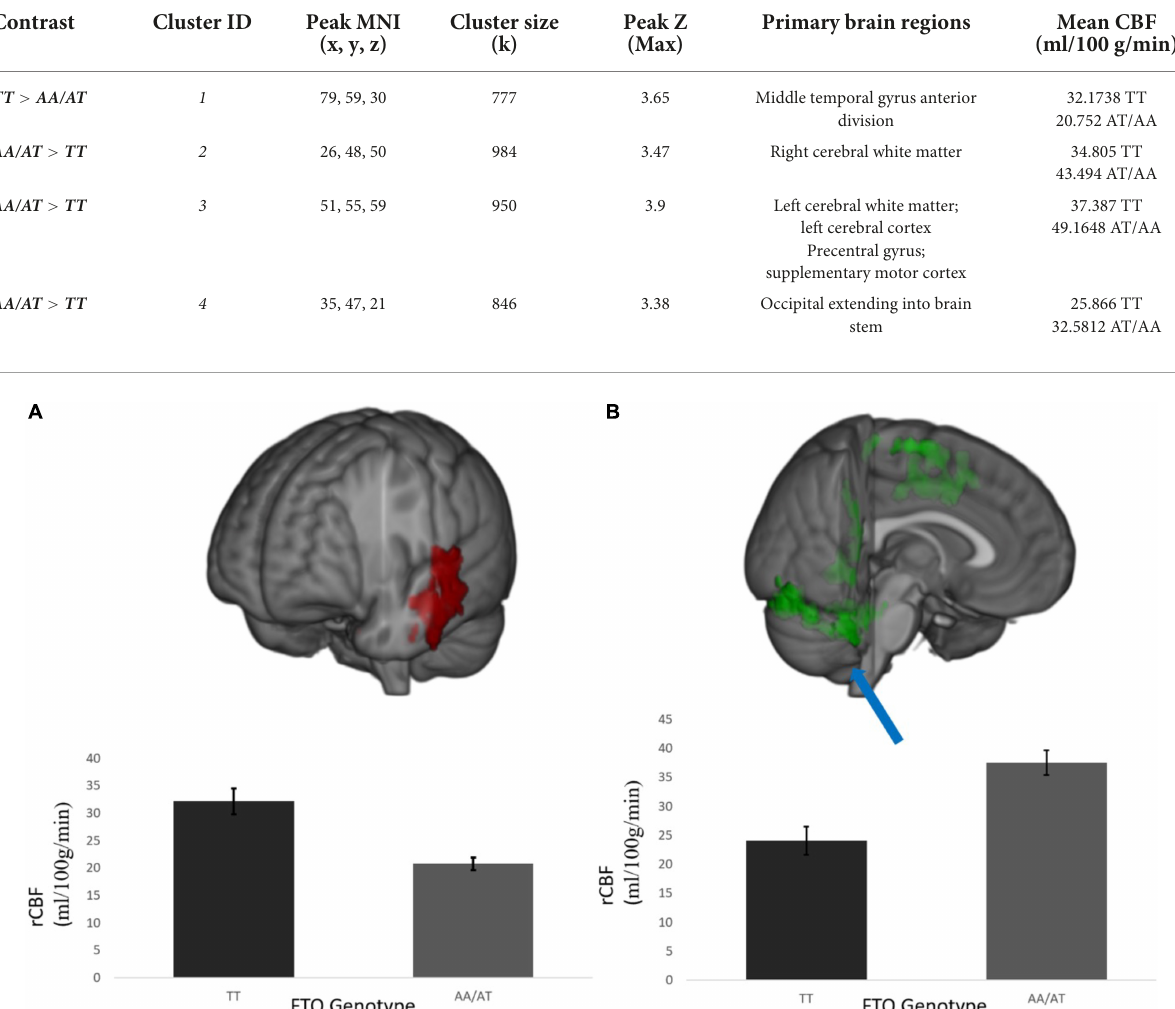
TABLE 3 Clusters showing main effect of the FTO group (T/T homozygote vs. A carrier) on resting cerebral perfusion (rCBF).